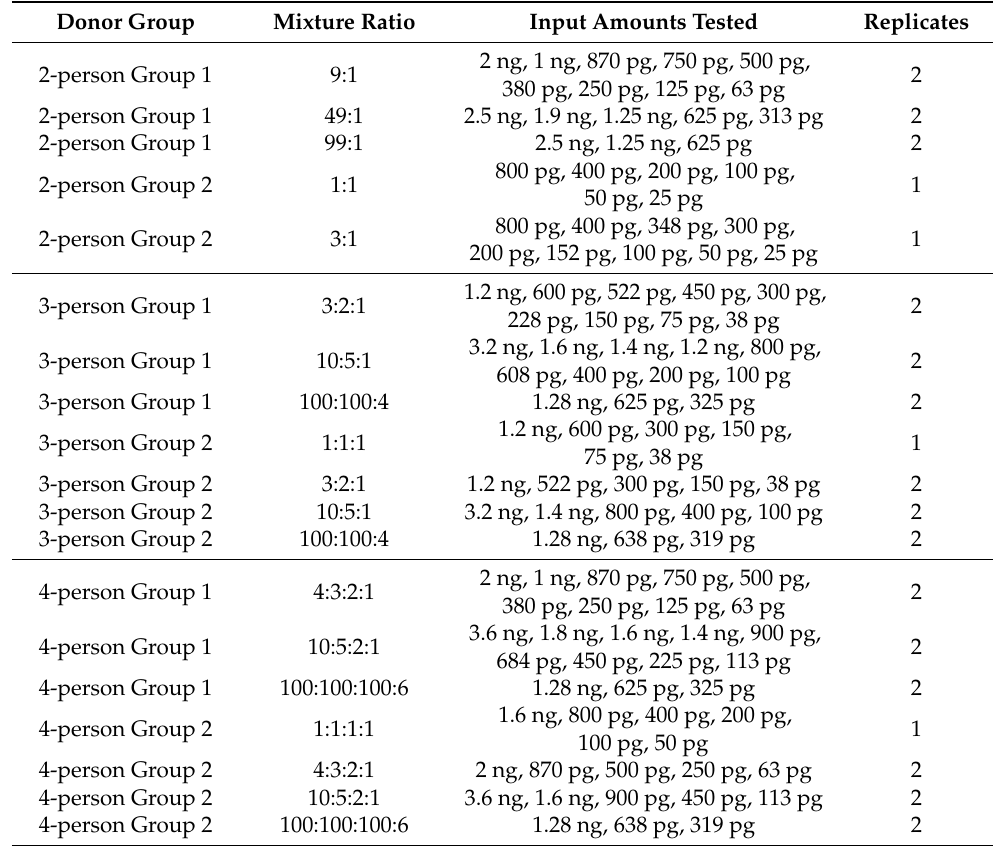
Table 2. Sample composition of mixtures for compound/conditioned LRs. Donor mixture ratios are listed from left to right in accordance with the donor numbers listed in Table 1. The input amounts listed are for total DNA. Donor